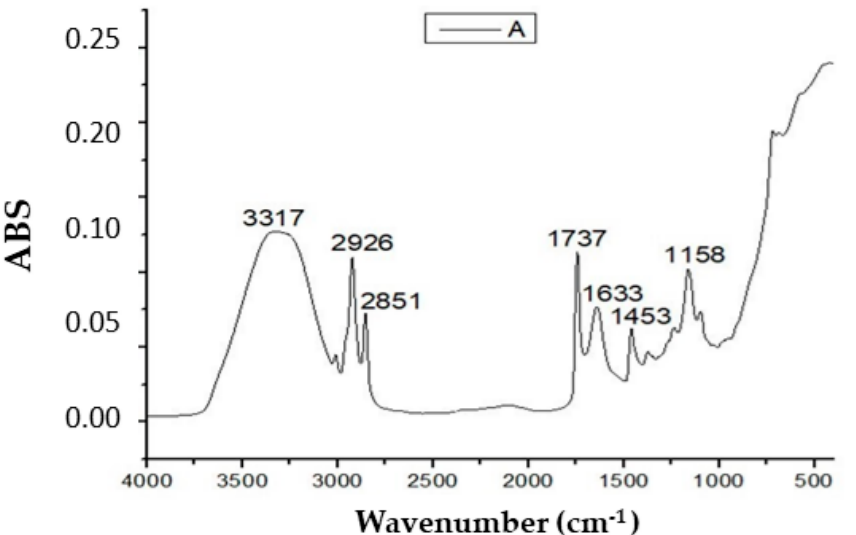
Figure 5. Fourier-transform infrared (FTIR) analysis of BS produced by Pantoea alhagi strain Zcb15.